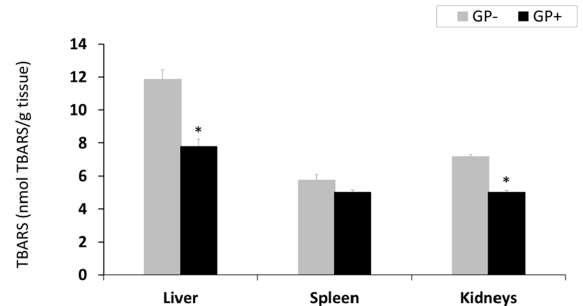
Figure 1. Lipid peroxidation (nmol TBARS/g tissue) as determined by the TBARS assay, in the liver, spleen and kidneys samples (n = 10); * = statistically significant when GP− was compared with GP+. Total antioxidant status (TAS). Assessment of TAS showed a higher antioxidant status in the liver compared to the spleen and kidneys; for all three organs, a significant ( p < 0.05) increase was noticed in the case of GP+ diet compared to the control (43.94 μmol/g tissue GP+ vs 34.63 μmol/g tissue GP−for liver, +21%, 22.15 μmol/g tissue GP+ vs 17.68 μmol/g tissue GP−for spleen, +20% and 20.71 μmol/g tissue GP+ vs 18.3 μmol/g tissue GP−for kidneys +11%, (Figure 2).